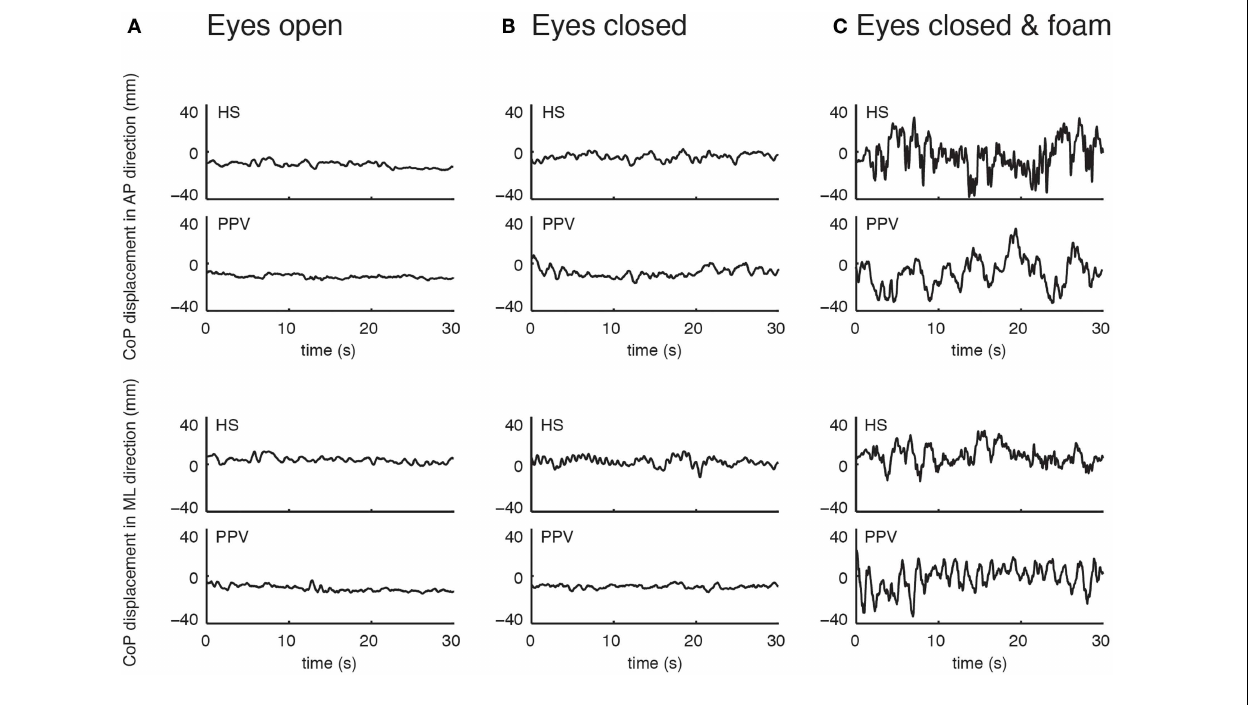
FIGURE 1 | Example of time series of center of pressure displacement in the anterior-posterior (AP) direction (upper panel) and the medial-lateral (ML) direction (lower panel) for one patient